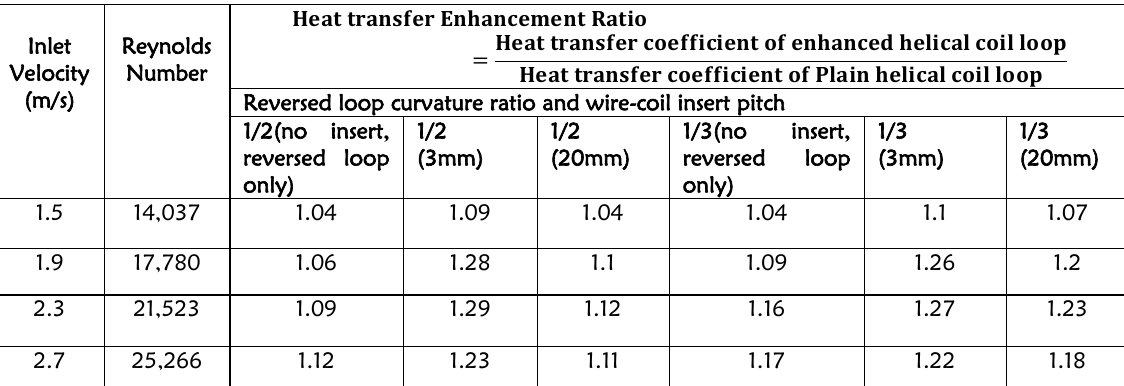
Table 1: Heat transfer enhancement for helical coils with reversed loops and wire coil inserts [21].